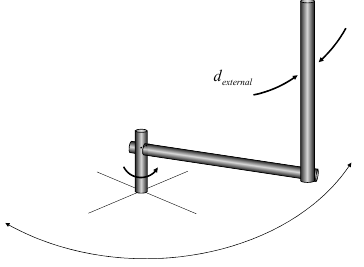
Figure 7. External disturbance in the